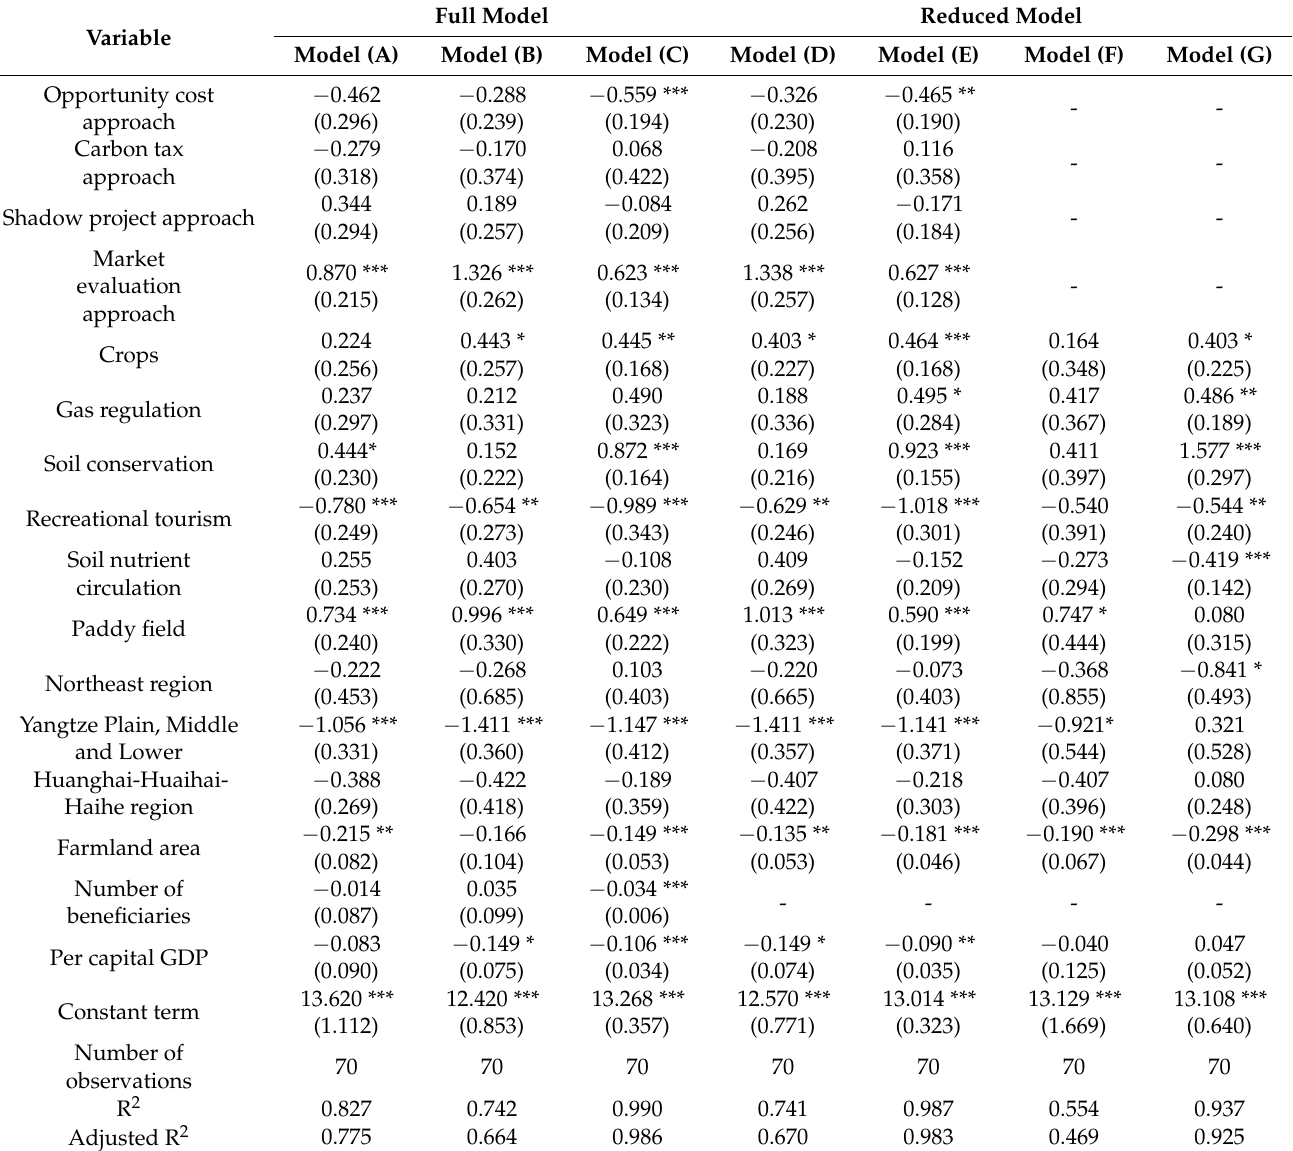
Table 2. Estimated meta-regression value transfer function.